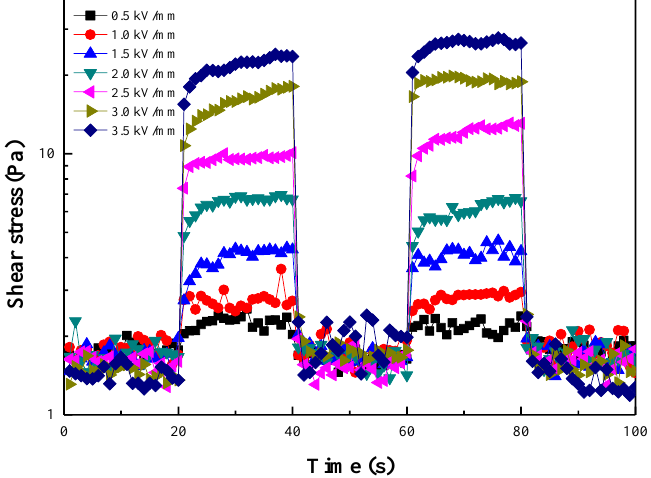
. Figure 13. Shear stress of the ER fluid at 𝛾̇ = 1 s − 1 under different E with a square voltage pulse for Figure 13. Shear stress of the ER fluid at γ = 1 s − 1 under different E with a square voltage pulse for 20 s.